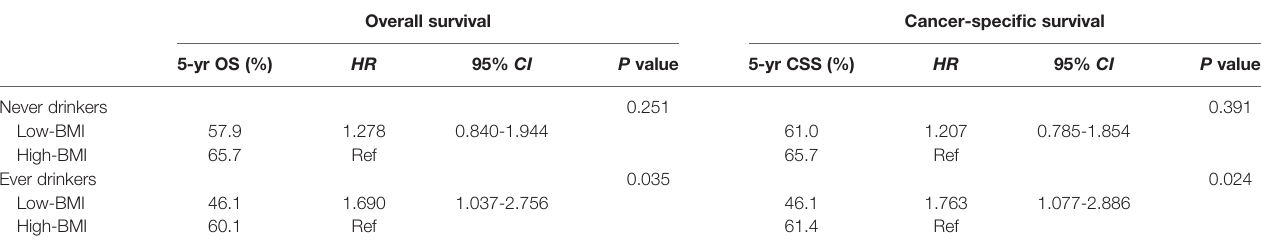
BMI, body mass index; CI, con fi dence interval; CSS, cancer-speci fi c survival; HR, hazard ratio; OS, overall